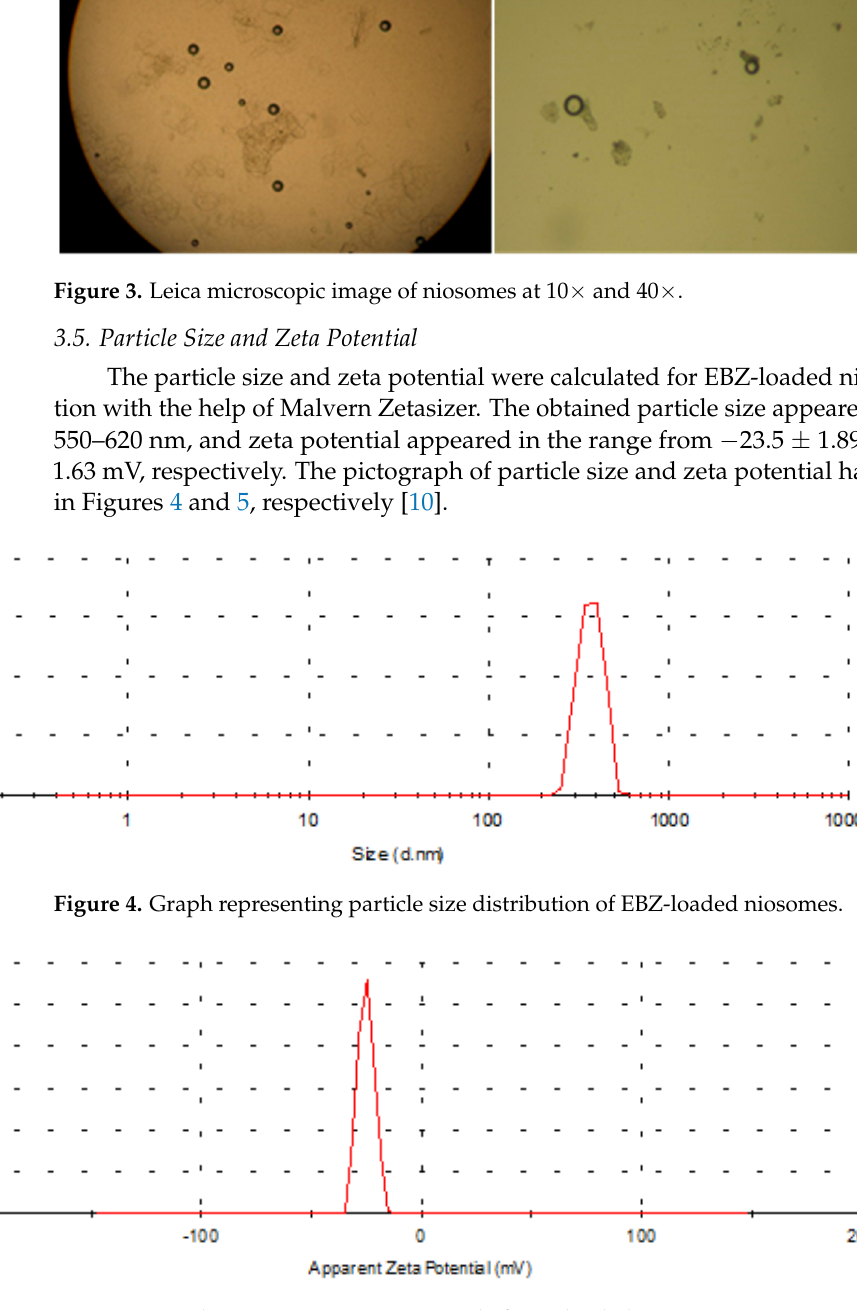
Figure 2. Standard calibration curve of EBZ.